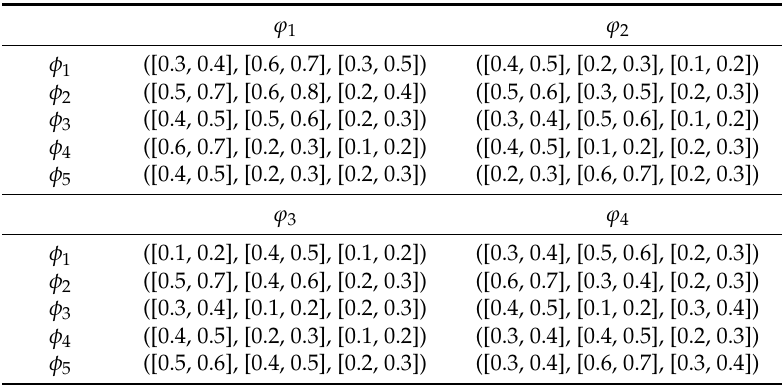
Table 1. The decision matrix (cid:101) R 1 .